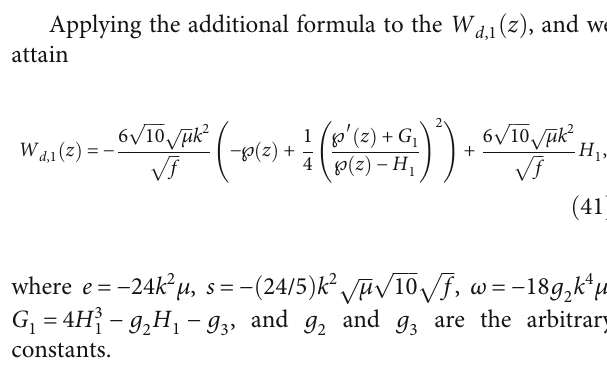
ð z Þ for the fi xed r ,2 Figure 8: Perspective view of 3D graph of W values ω = 6 , z 0 = − 1/8 , μ = 1 , k = 1 , s = 1 , e = 1 , and α = 1 represents exact